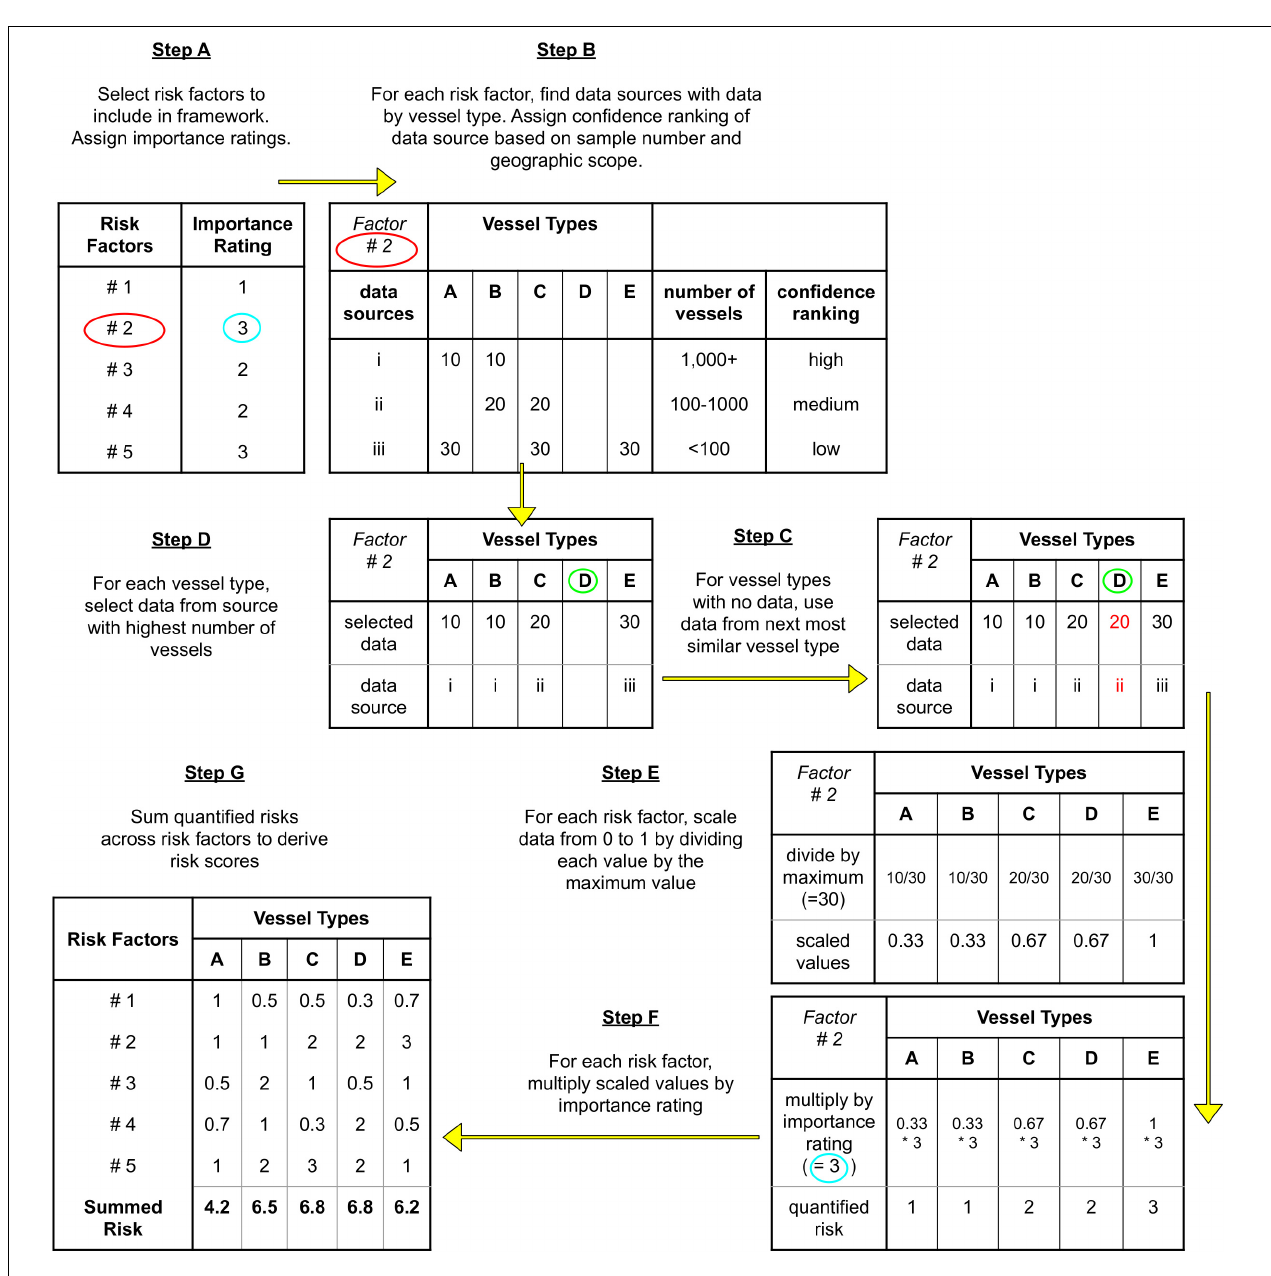
FIGURE 1 | An overview of the seven-step methodology that we used to populate the vessel biosecurity risk framework with data from empirical sources. Numbers in this overview are examples only, to demonstrate the data selection process and calculations. Colored circles are provided to help with tracking links between the steps. Individual steps (A–F) are described in detail in the main